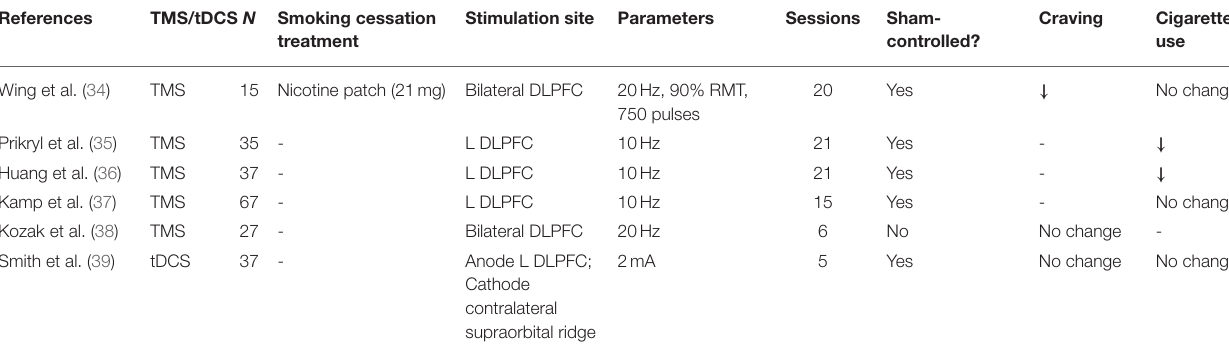
TABLE 1 | Comparison of studies using NIBS for nicotine dependence in